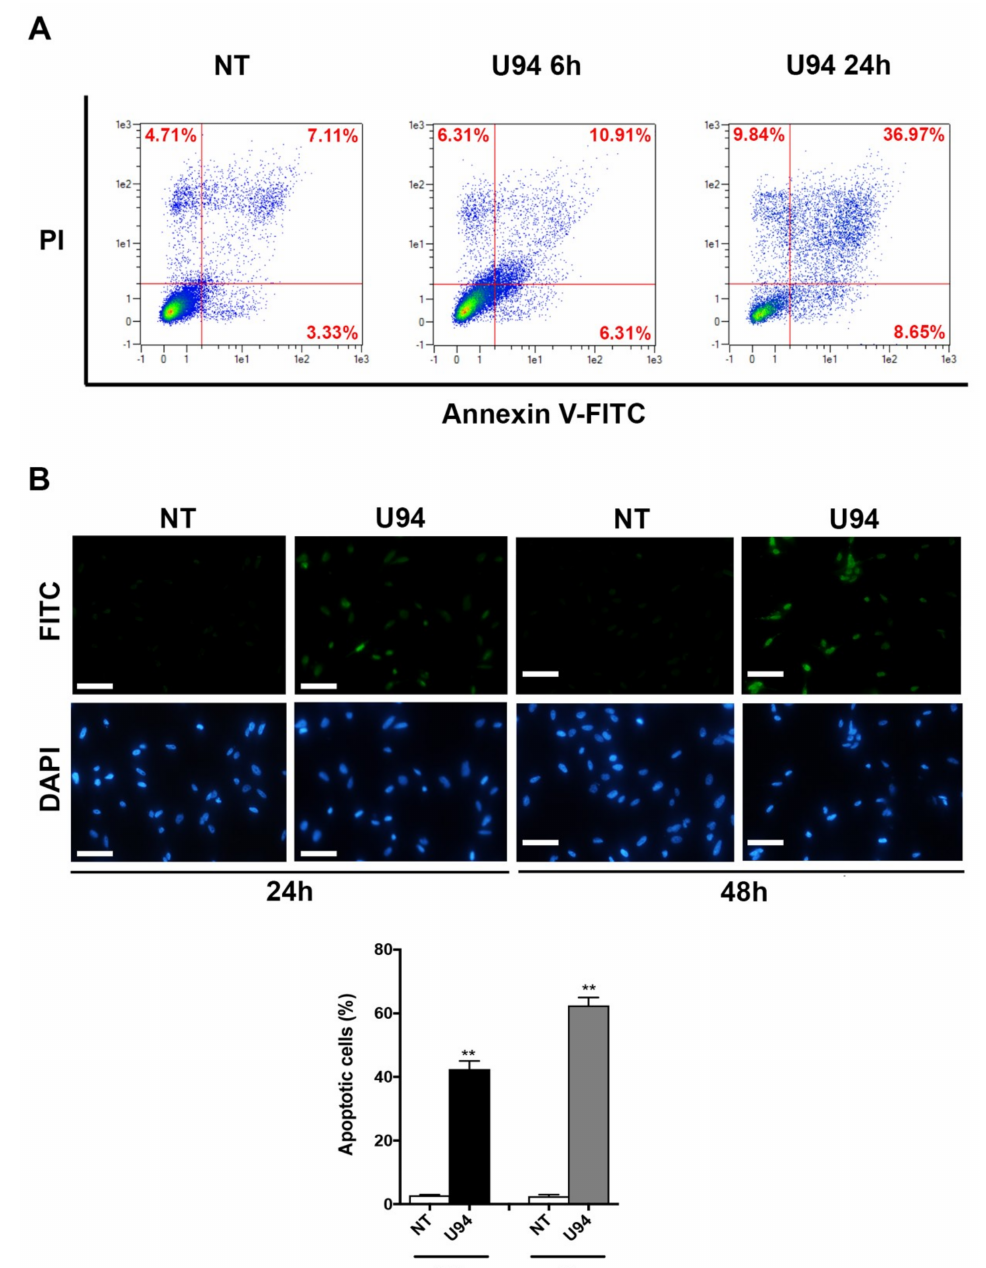
Figure 4. U94 expression in MDA-MB 231 cells induces apoptosis. ( A ) MDA-MB 231, 6 and 24 h post-transduction, were stained with Annexin V-FITC and PI. Apoptosis was assessed by flow cytometry. The four quadrants represent living cells (lower left), early apoptotic (lower right), late apoptosis (upper right) or necrotic (upper left) stages. Values represent the percentages of each quadrant. ( B ) Terminal deoxynucleotidyl transferase-mediated dUTP Nick End Labeling (TUNEL) staining in MDA-MB 231 cells transduced or not with amplicons for 24 and 48 h. DAPI staining was used to visualize the cell nucleus. The histograms represent the mean ± SD of apoptotic cells from two independent experiments performed in triplicate. Statistical analysis was performed by unpaired Student’s t -test, ** p < 0.01. Scale bar: 100 µ